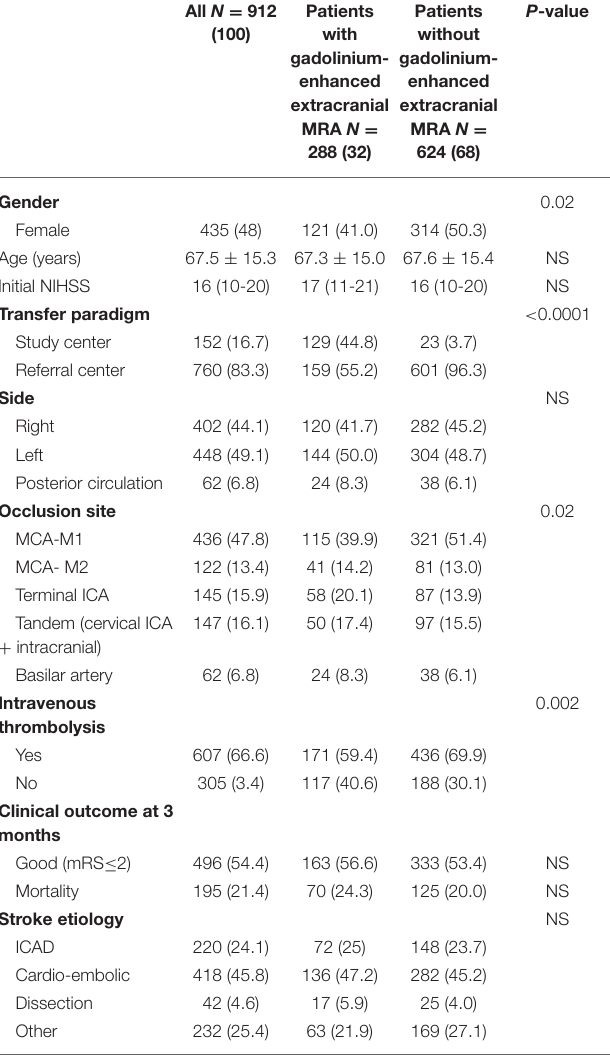
TABLE 1 | Patients characteristics and clinical outcomes. TABLE 2 | MT